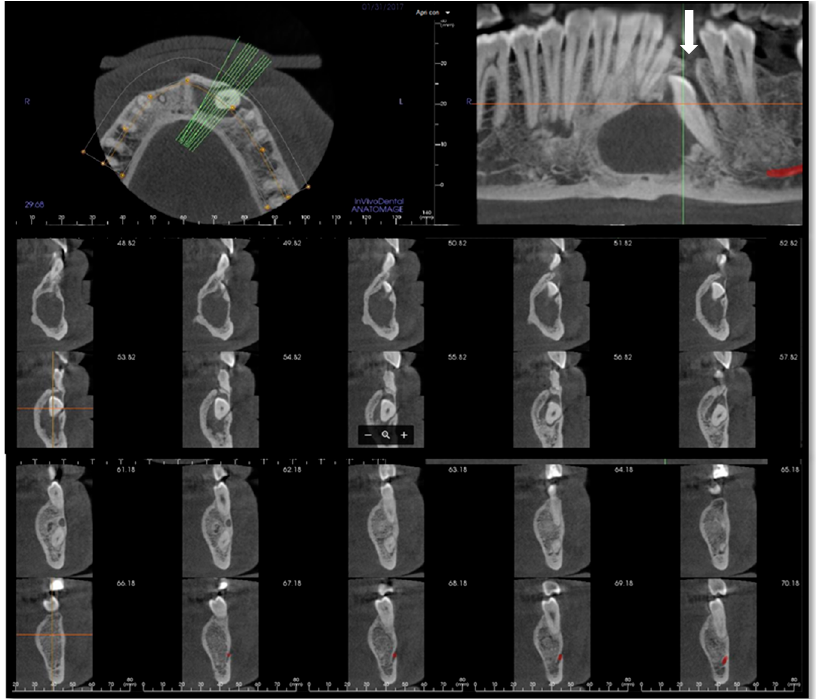
Figure 2. Cone-beam computed tomography (CBCT) of the mandible performed in January 2017 after the first infective episode and showing no atypical radiologic findings. The osteolytic alveolar defect ( white arrow ) has led to the recurrent oral discharge.